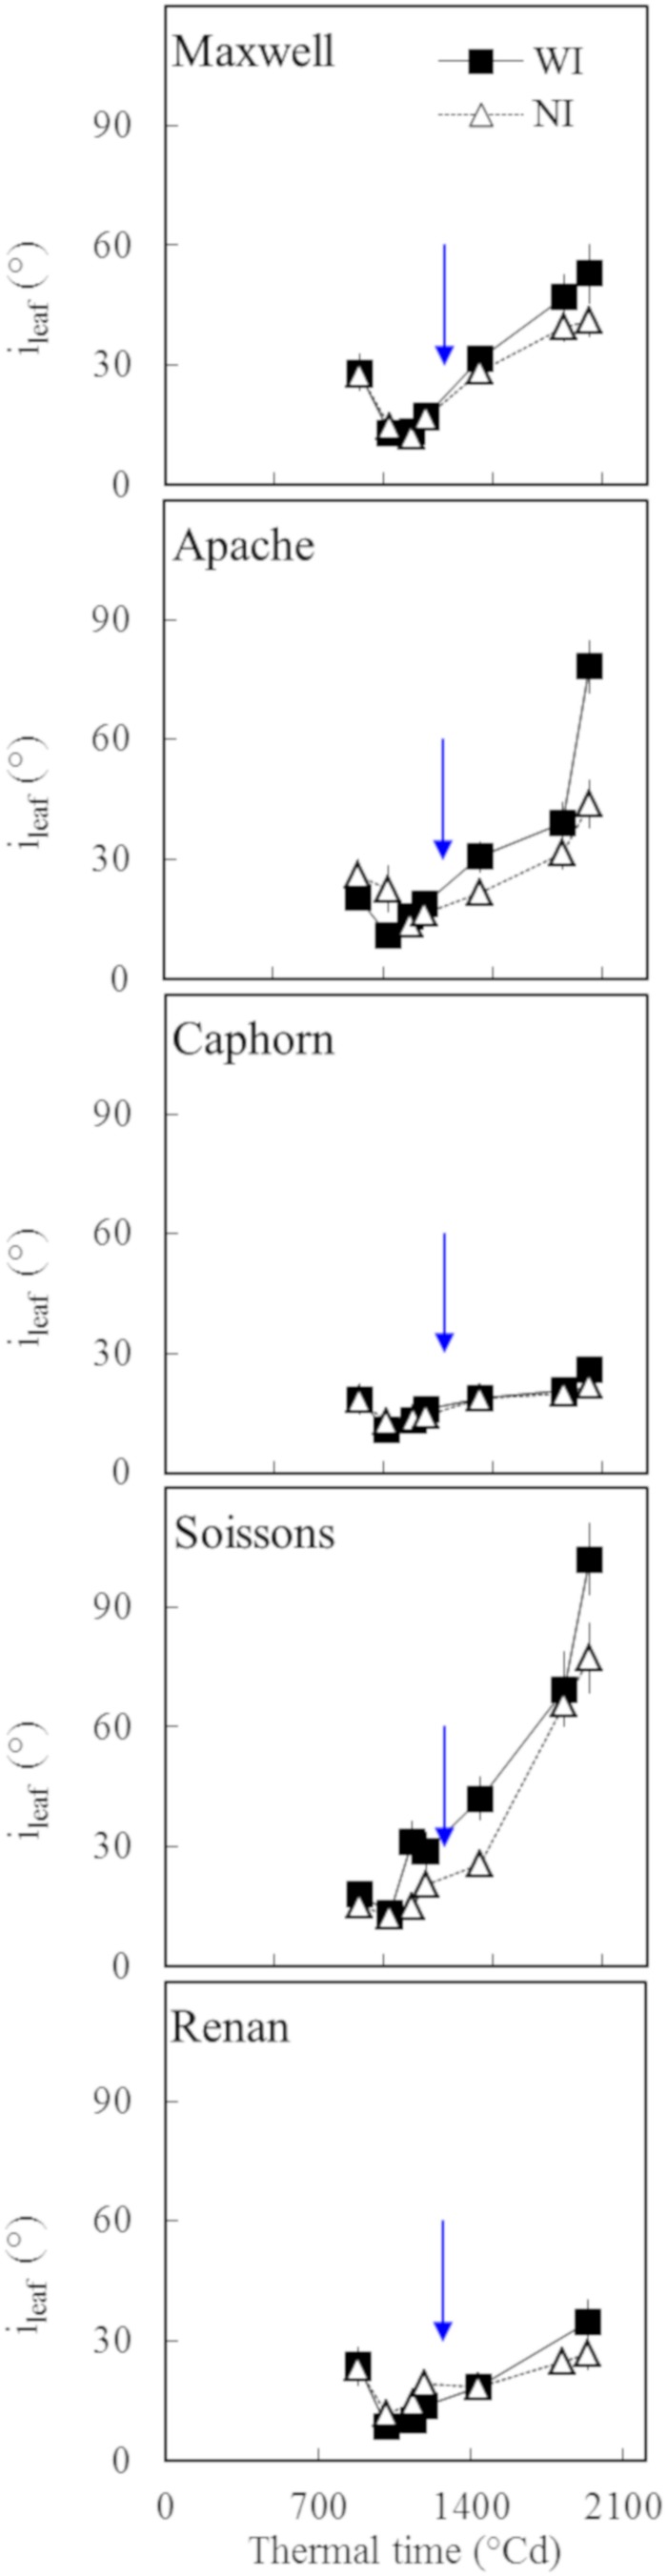
The insertion angle (ileaf) averaged over the four upper leaves of the main stem vs. the thermal time from plant emergence. Each symbol represents the mean of values measured on 30 plants. Squares and solid lines represent the WI treatment, while triangles and dotted lines represent the NI treatment. Only leaf blades, having at least 20% green area, were taken into account. Error bars mark 95% confidence intervals of the mean estimates. The arrow indicates the second date of digitalization (1272°Cd), which is close to ear emergence date.